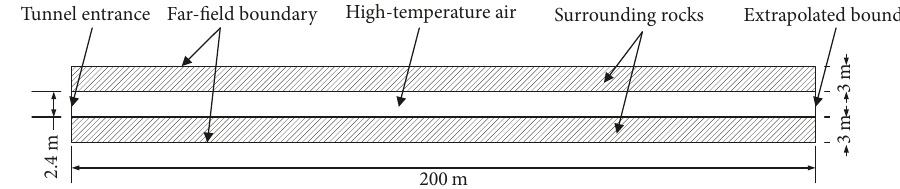
Figure 4: Schematic illustration of the numerical model.